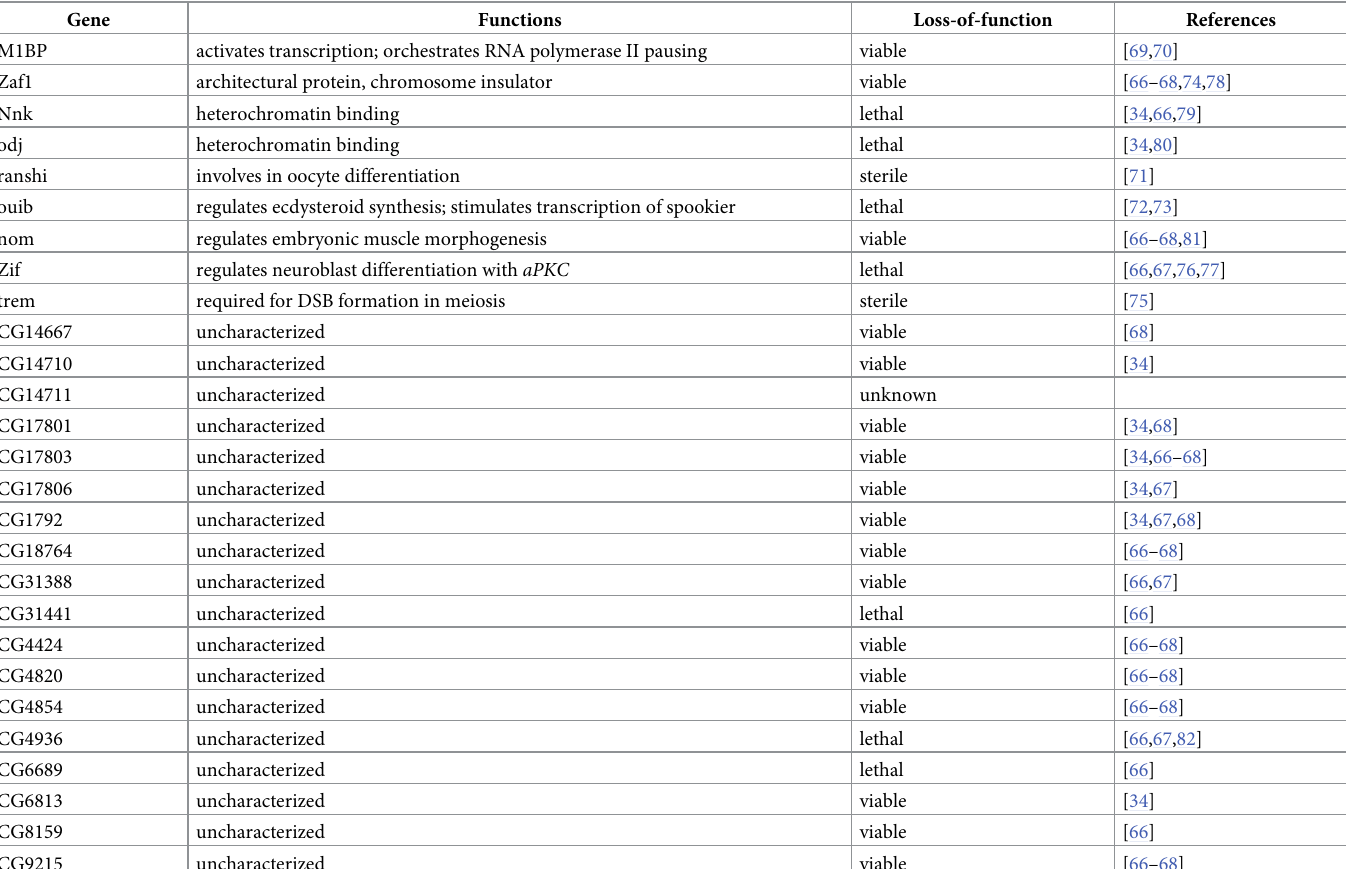
Table 2. Functions of D . melanogaster cucoid